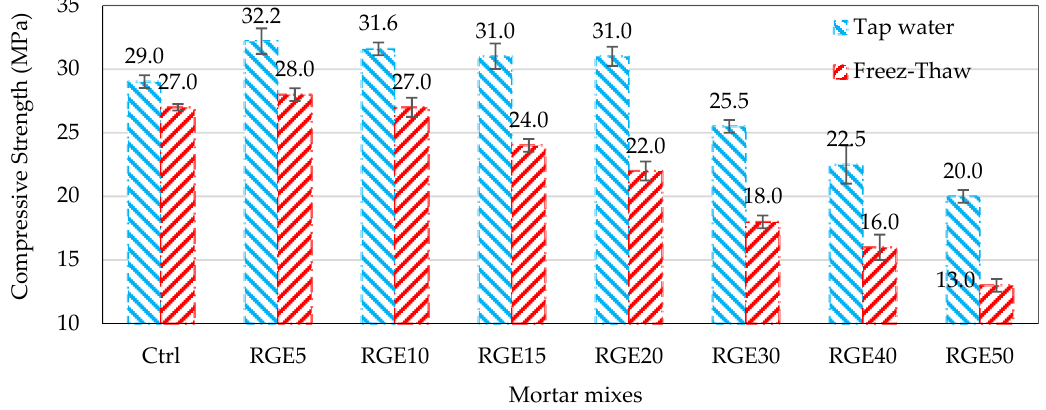
Figure 11. Compressive strength of specimens at 28 days (tap water and freeze–thaw cycles).